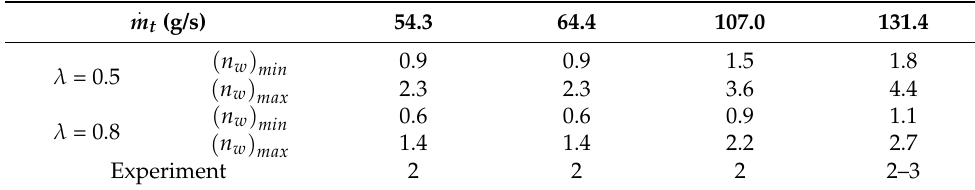
Table 5. Predicted detonation wave number.